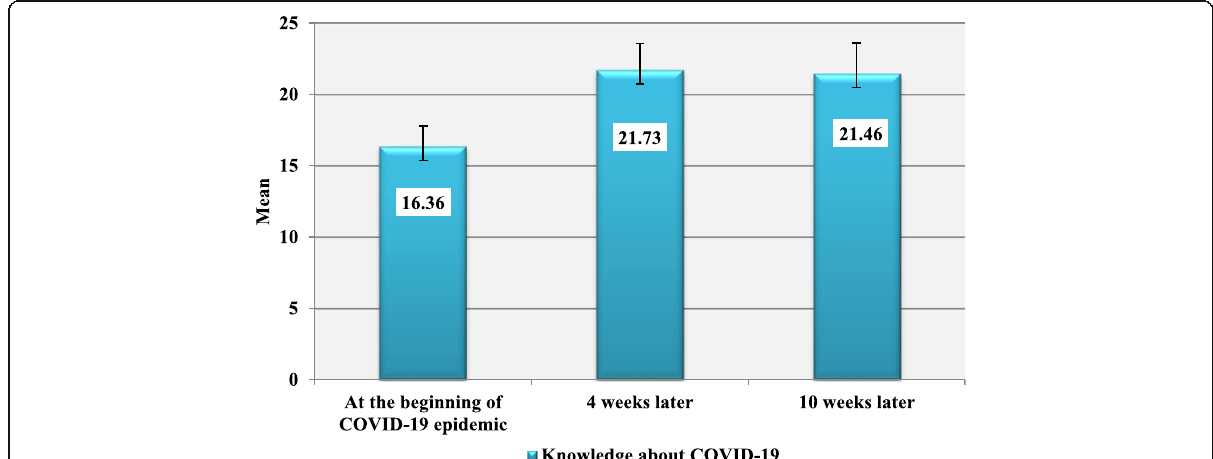
Fig. 1 Distribution of total knowledge about COVID 19 among participants over the three periods of time